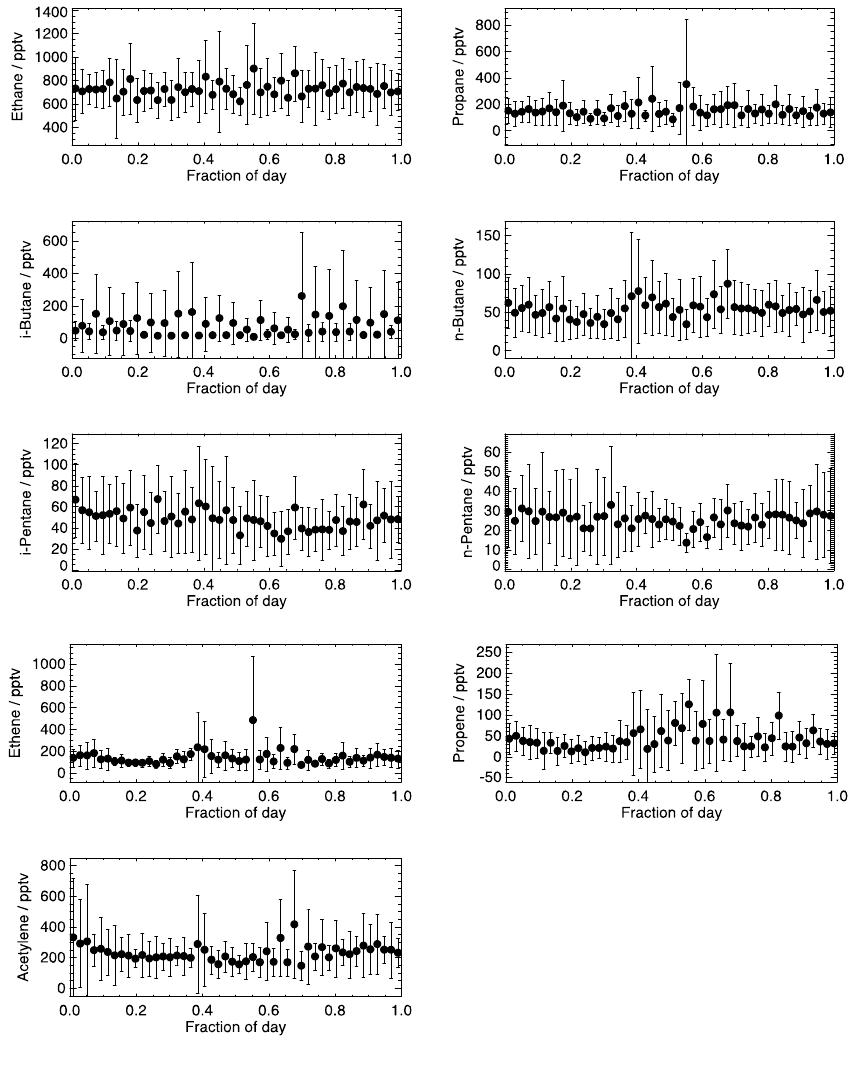
7Figure 1: Average diurnal cycles (local time) of measured species used to constrain the model, averaged into 30 min time bins, with error bars indicating the 1 σ variability on the observations. All average values are means, except for NO 2 where the median has been used due to large spikes in the data. For hydrocarbons where the sampling period was less than every 30 min, the data were interpolated between their measurement